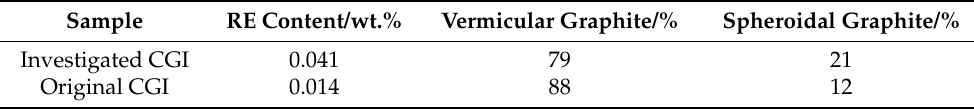
Figure 2. A micrograph of the microstructure of the investigated CGI alloyed by RE: ( a ) OM-etched microstructure image, ( b ) spheroidal graphite, ( c , d ) vermicular graphite, and ( e ) pearlite lamellar spacing by SEM images. Table 3. Comparison of different graphite content